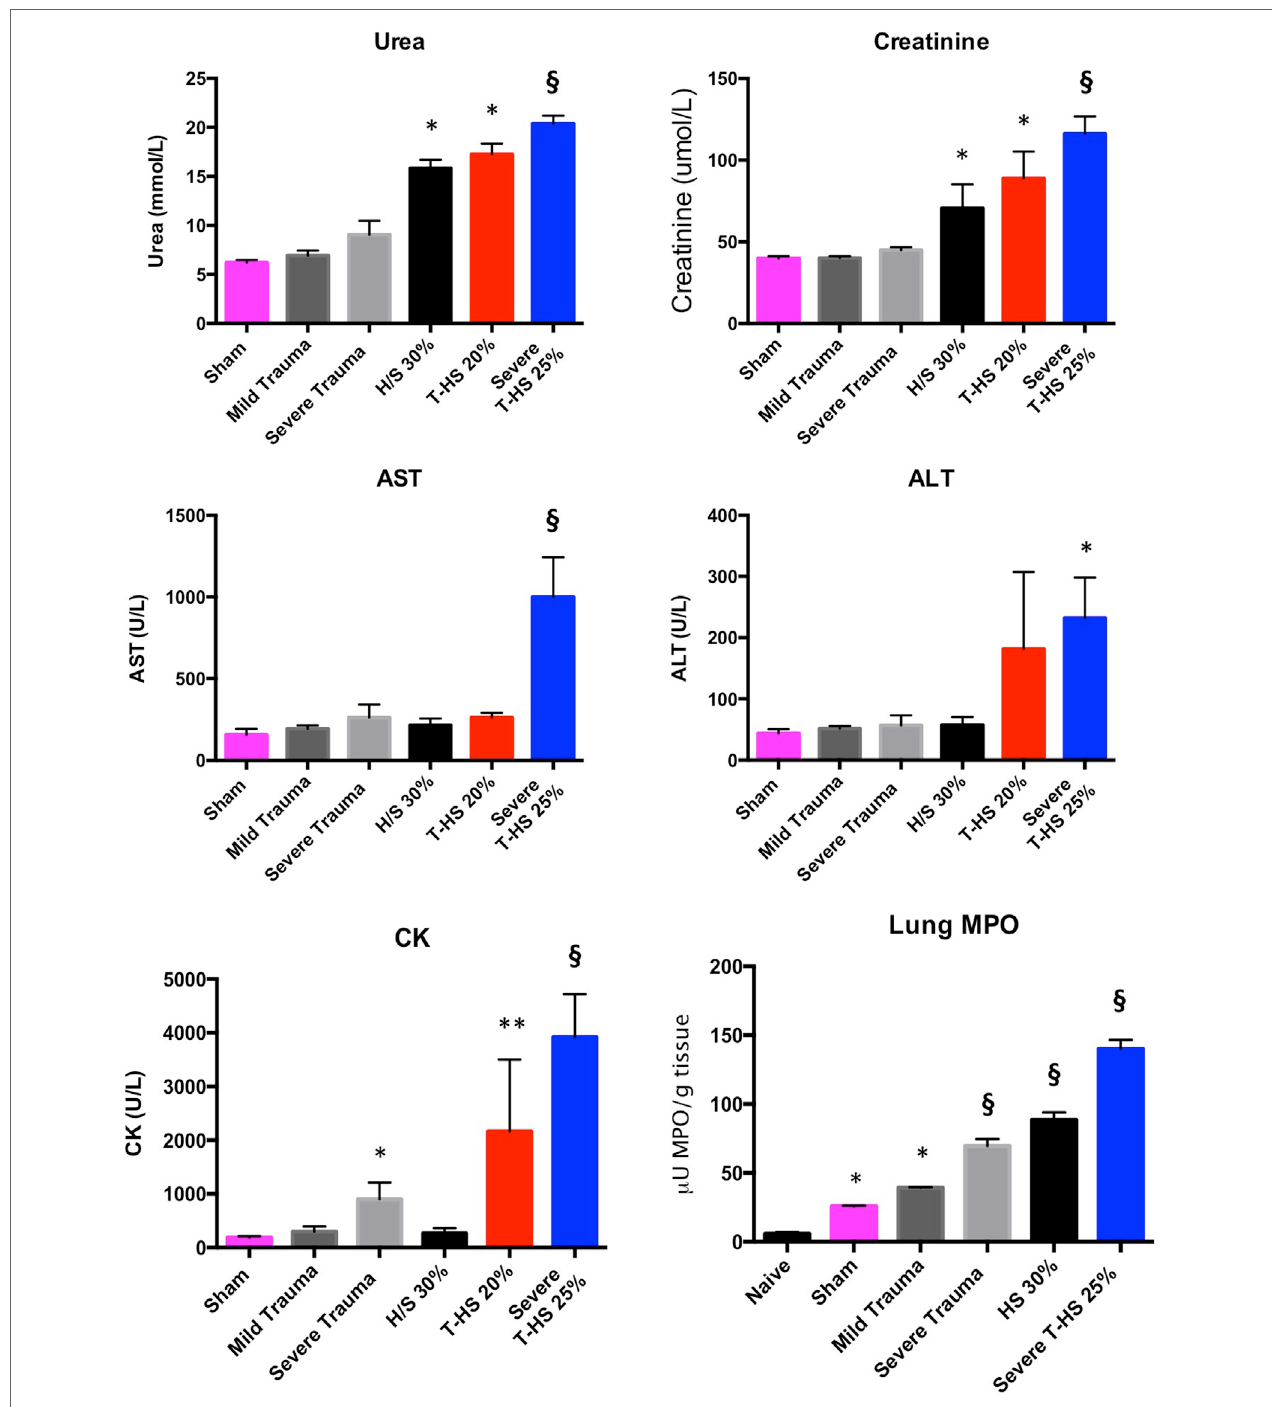
FigUre 2 | Organ injury plasma biomarkers in various models of (trauma) hemorrhage. Trauma was inflicted during − 5 to 0 min. Naïve group, uninstrumented animals, n = 4. Sham group, instrumented animals, n = 8. Mild trauma group: Left leg fracture only, n = 6. Severe trauma: Bilateral leg fractures, 4-cm laparotomy, 10-s bilateral leg muscle crush injury, n = 8. HS 30% group: Bleeding of 30% circulating volume for 20 min, n = 8. T-HS 20% group: Bilateral leg fractures, 4-cm laparotomy, bleeding 20% circulating volume for 20 min, n = 8. Severe T-HS 25% group: Bilateral leg fractures, 4-cm laparotomy, 10-s bilateral leg muscle crush injury, bleeding 25% circulating volume for 35 min, n = 8. * denotes p < 0.05 vs sham; ** denotes p < 0.01 vs sham; § denotes p < 0.0001 vs sham, all t -tests. For lung Myeloperoxidase (MPO) symbols denote significance vs naïve animals, n = 4 (uninstrumented controls). For creatine kinase (CK), § also denotes p < 0.0001 for severe T-HS 25% vs severe trauma alone. Mean values ± SEM bars